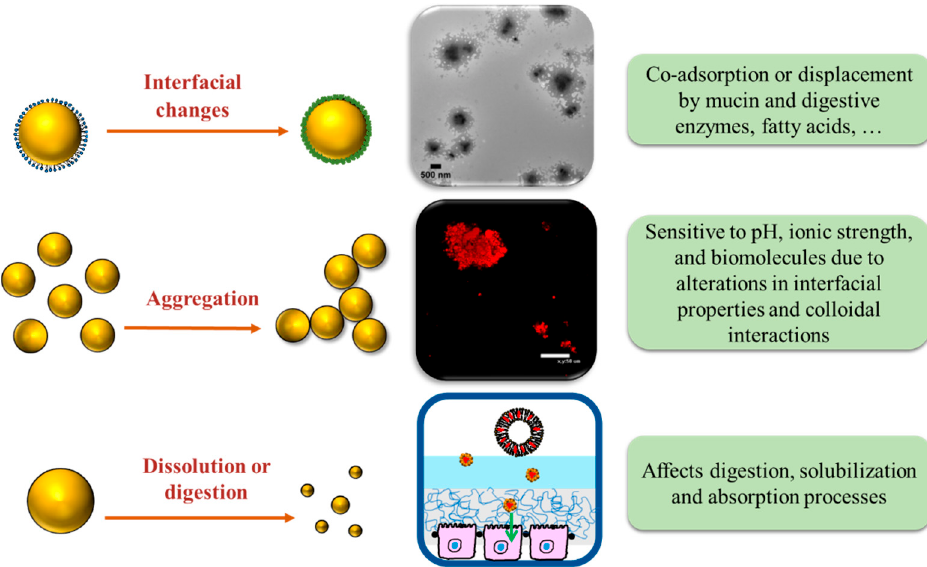
Figure 4. Schematic representation of changes in the properties of nanoparticles within the GIT after ingestion. Transmission electron microscopy (TEM) and confocal laser scanning microscopy (CLSM) images are adopted from our previous studies [68,69]. The scale bars are 0.5 and 50 µ m, respectively.